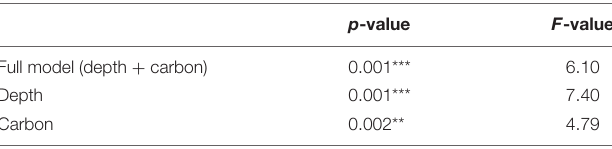
TABLE 5 | Results of canonical correspondence analysis using Monte-Carlo permutation test, performed on a traits by stations matrix for ROV samples of epibenthos in the Arctic Chukchi Borderland. p -value F -value Full model (depth + carbon) 0.001*** 6.10 Depth 0.001*** 7.40 Carbon 0.002**